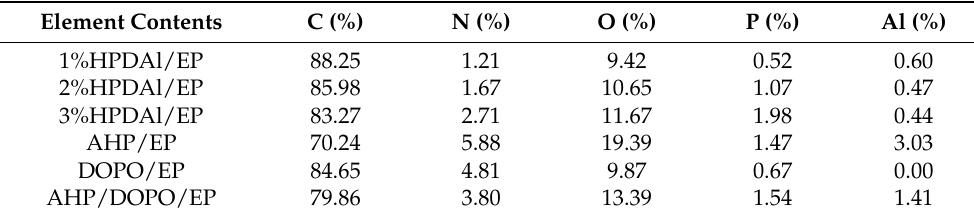
Table 5. Elemental concentrations of residues of EP composites from XPS.